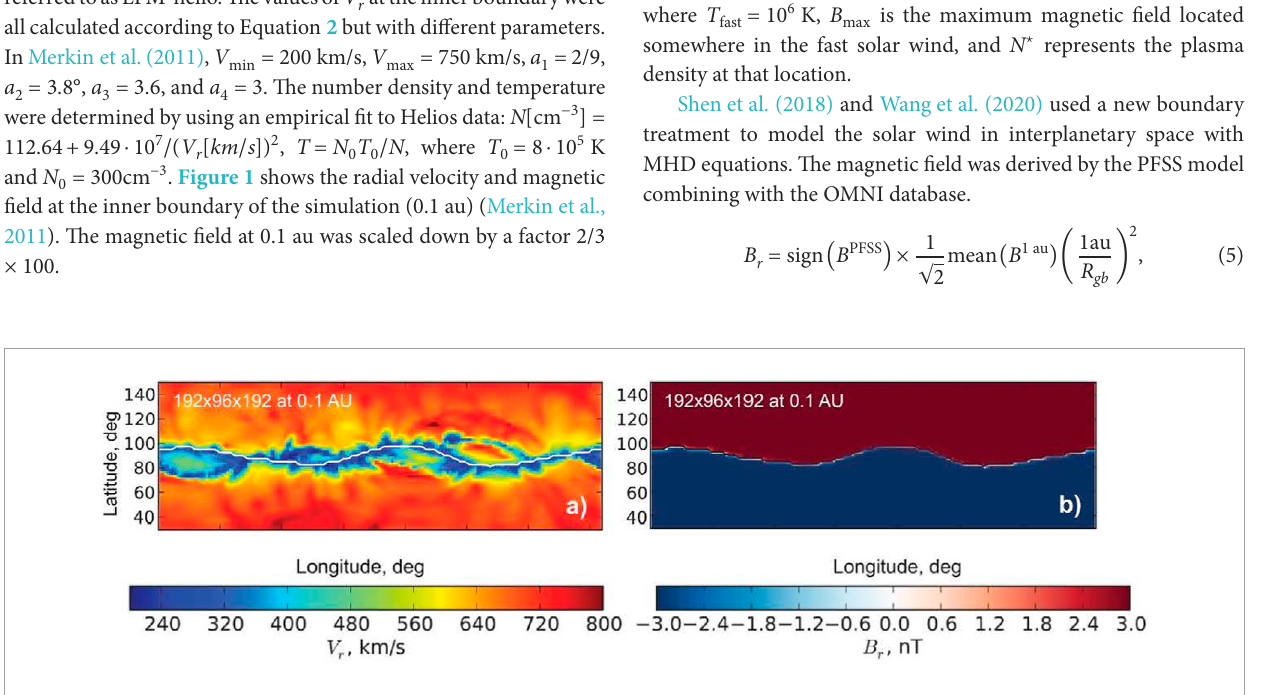
FIGURE 1 Radial velocity (A) and magnetic field (B) at the inner boundary of the simulation (0.1 au) (Merkin et al., 2011).